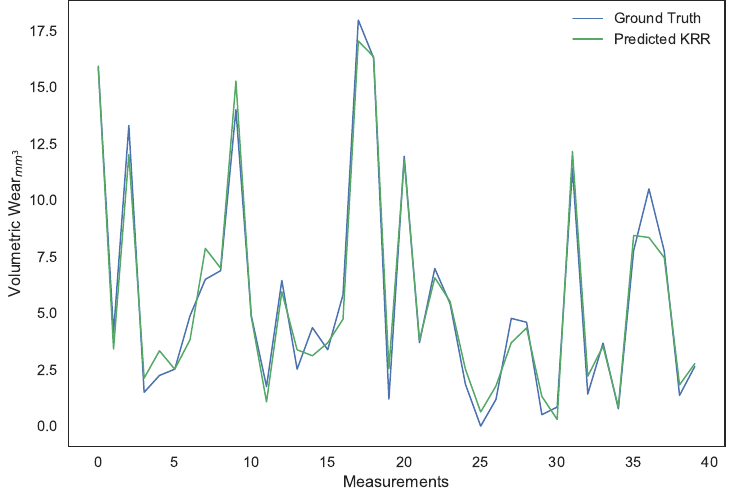
Figure 15. Surface wear prediction on the validation set using χ 2 kernel ridge